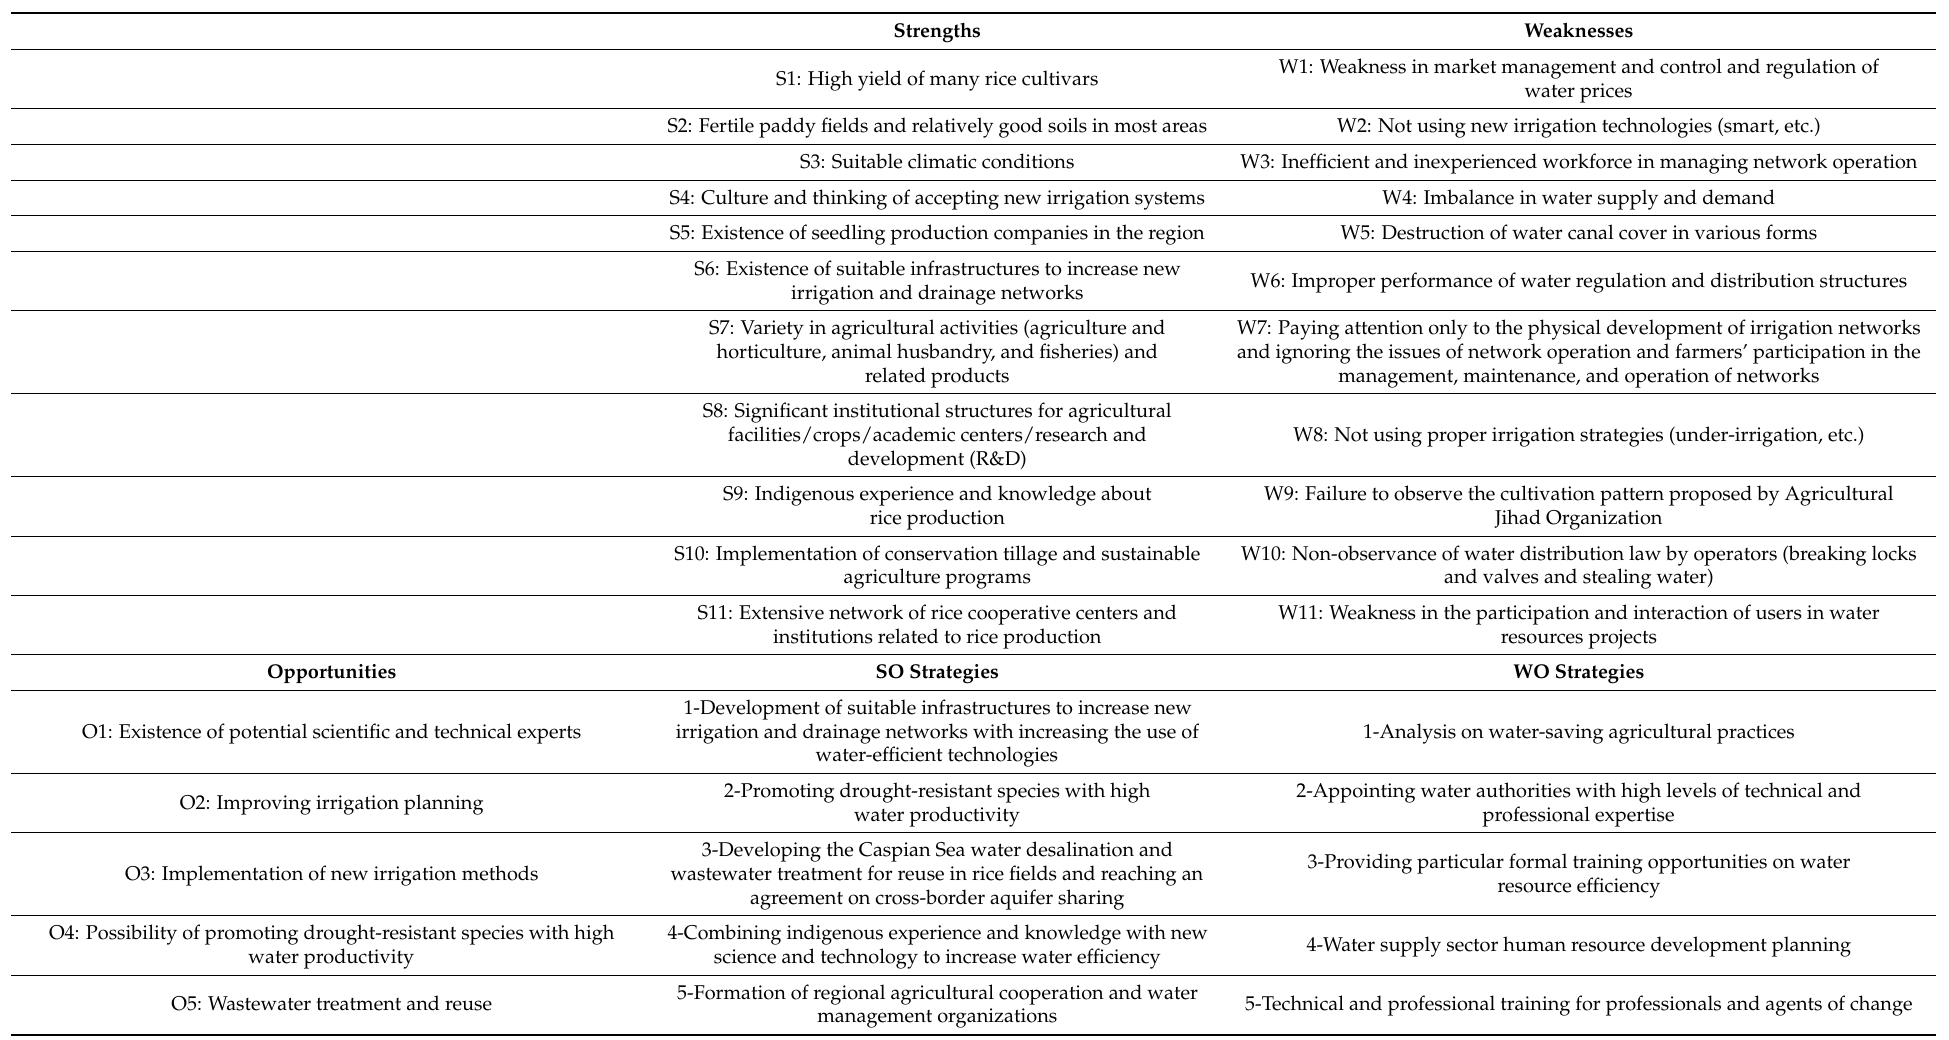
Table 4. QSPM results analysis for SWOT strategy to improve water